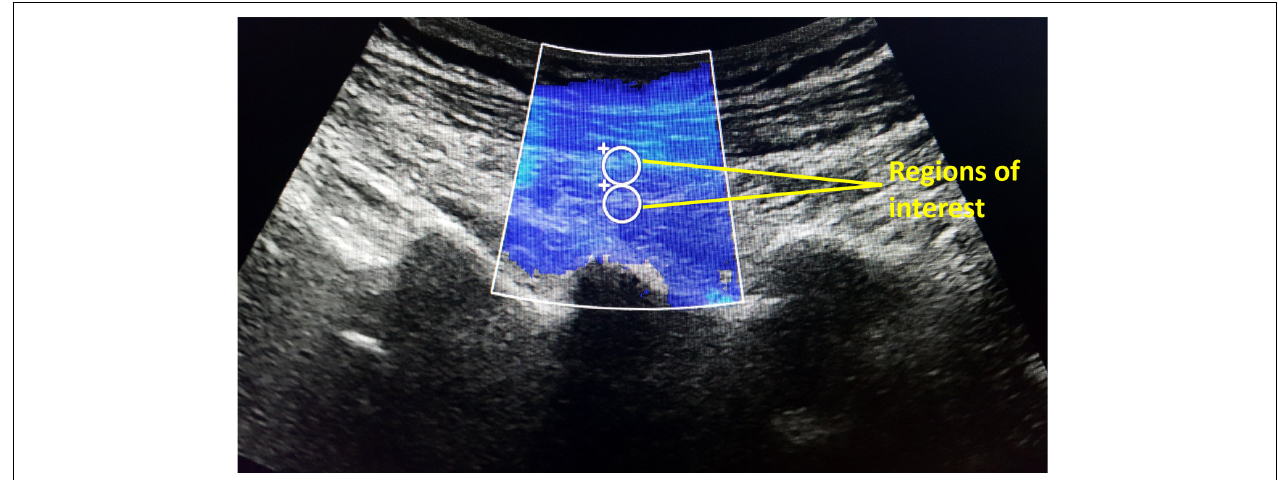
FIGURE 2 | The supersonic shear wave imaging for lumbar multifidus stiffness measurements based on average pixel intensity within two regions of interest (5 mm diameter).